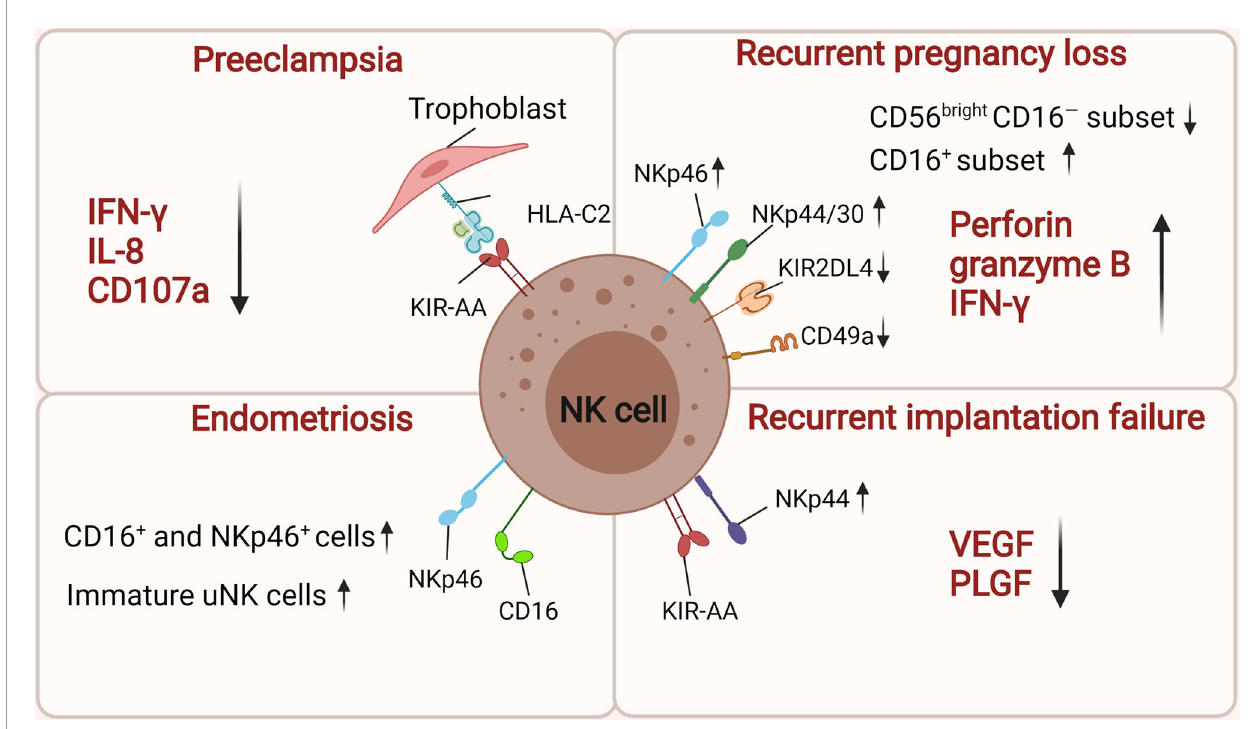
FIGURE 2 | The roles of uNK cells in related pregnancy complications. There is high risk of women suffering PE if they carry alleles for KIR AA genotype on maternal NK cells when the trophoblast expresses HLA-C2. The inhibition of dNK activation by downregulating IFN- g , IL-8 and CD107a contributes to the onset of preeclampsia. uNK cells from women with RPL have low levels of CD49a, KIR2DL4, and high expression of NKp46/44/30, perforin, granzyme B, and IFN- g . Moreover, their cytotoxic CD16 + uNK cells populations is signi fi cantly increased while the CD56 bright CD16 − NK cells subset is signi fi cant decrease. In women with endometriosis, the number of CD16 + , NKp46 + uNK cells and immature uNK cells was signi fi cantly increased in the endometrium. Women suffering RIF express low levels of angiogenic factors (VEGF and PLGF) and those with a maternal KIR AA haplotype are more susceptible to suffering RIF after IVF treatment. The fi gure was created with